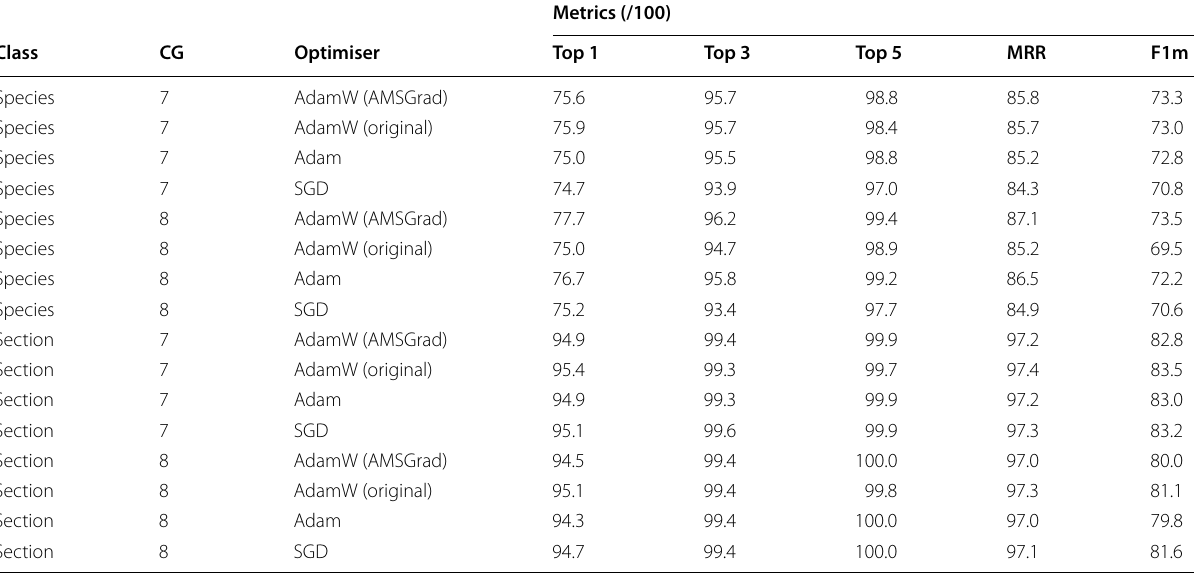
Table 8 Comparison of results with different functional optimizers